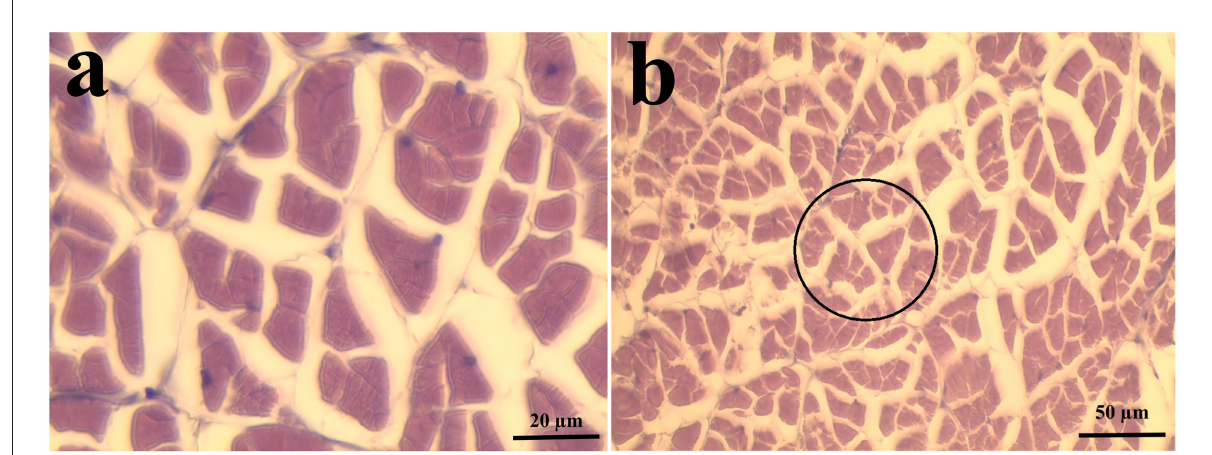
FIGURE1 Representative samples of shrimp muscle used in the morphometric measurements. (a) Sample section used in the determination of muscle cross-section area and mean fiber area/size ( n = 6 shrimp, 5 random frames per replicate; 1,000 × magnification; bar length = 20 µ m). (b) Sample section used in the determination of muscle fiber density ( n = 6 shrimp, 5 random circles per replicate, 400 × magnification; bar length = 50 µ m). Transverse, 4–5 µ m paraffin section, H and E stain, Davidson’s